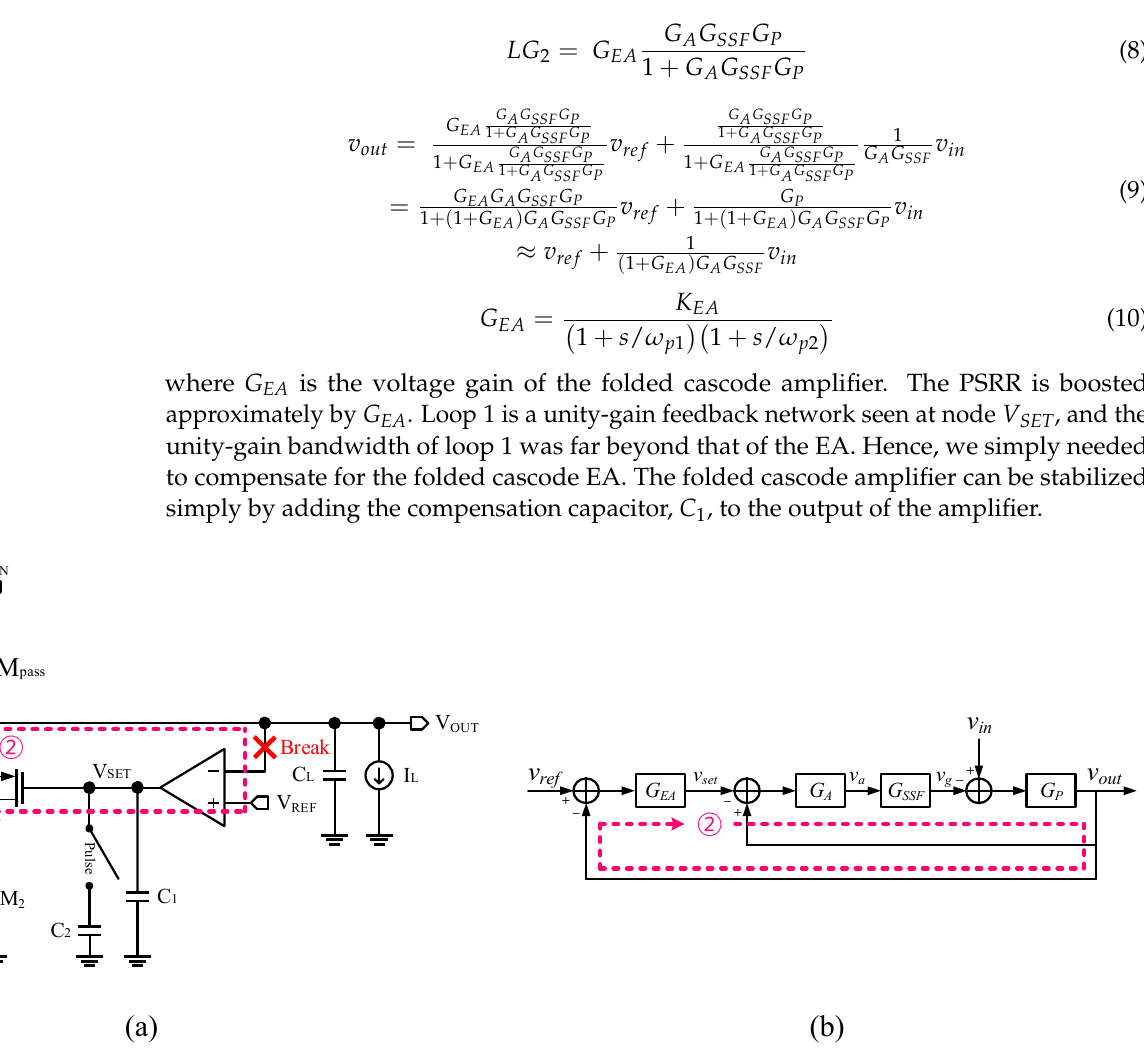
Figure 3. ( a ) Slow loop 2 broken at V SET and ( b ) its small-signal block diagram.